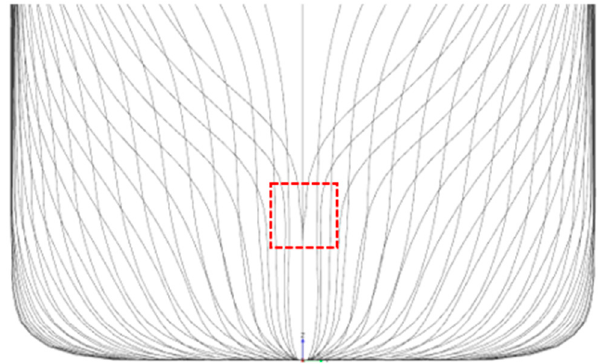
Figure 8. Line plan of reconstructed hull form KLE-4.